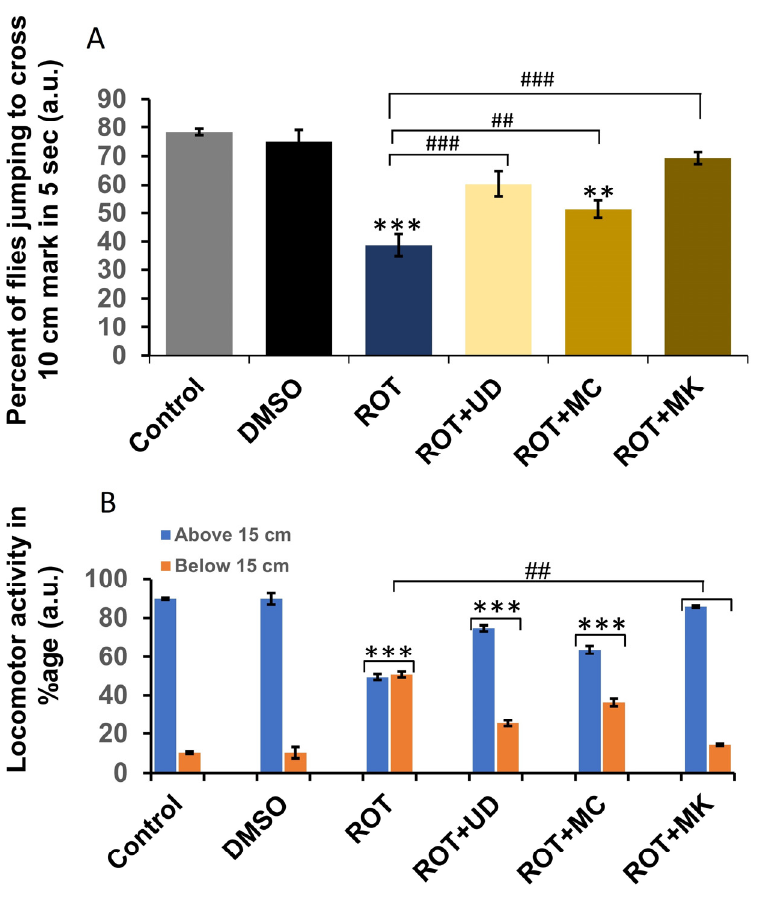
Figure 9. ( A ) Jumping and ( B ) climbing activity of D. melanogaster (Oregon R + ) flies exposed to ROT 500 µM alone or in combination with UD, MC, and MK for 120 h; significance is ascribed as ** p < 0.01, *** p < 0.001 vs. control or DMSO control. ## ascribed as significance at p < 0.01, ### p < 0.001 ### p < 0.001 compared with 500 µ M rotenone. UD = Urtica dioica , MC = Matricaria chamomilla and compared with 500 µM rotenone. UD= Urtica dioica , MC = Matricaria chamomilla and MK= Murraya MK = Murraya koenigii koenigii .